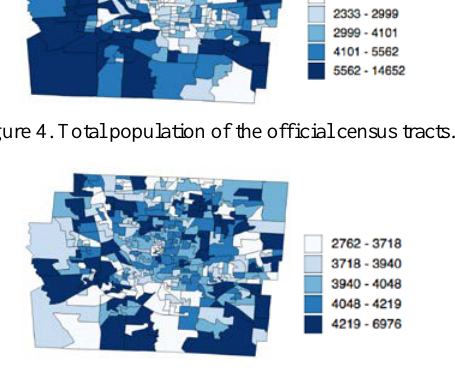
Figure 5. Total population of the 284 aggregated